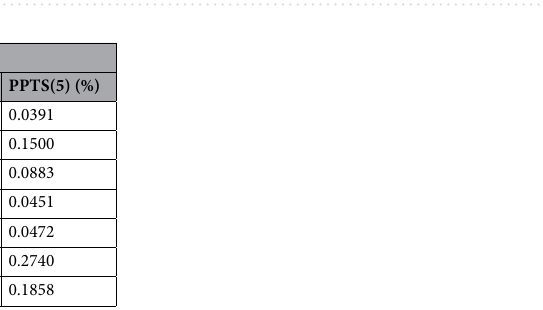
Figure 12. Comparison of forecasting results of the test dataset using the different feature learning models LSTM, DNN and SVR: ( a ) forecasting results, ( b ) scatters for the testing data (15/3/2013–31/12/2014), and ( c ) plots of the forecasting results during the period 07/09/2014–28/09/2014.